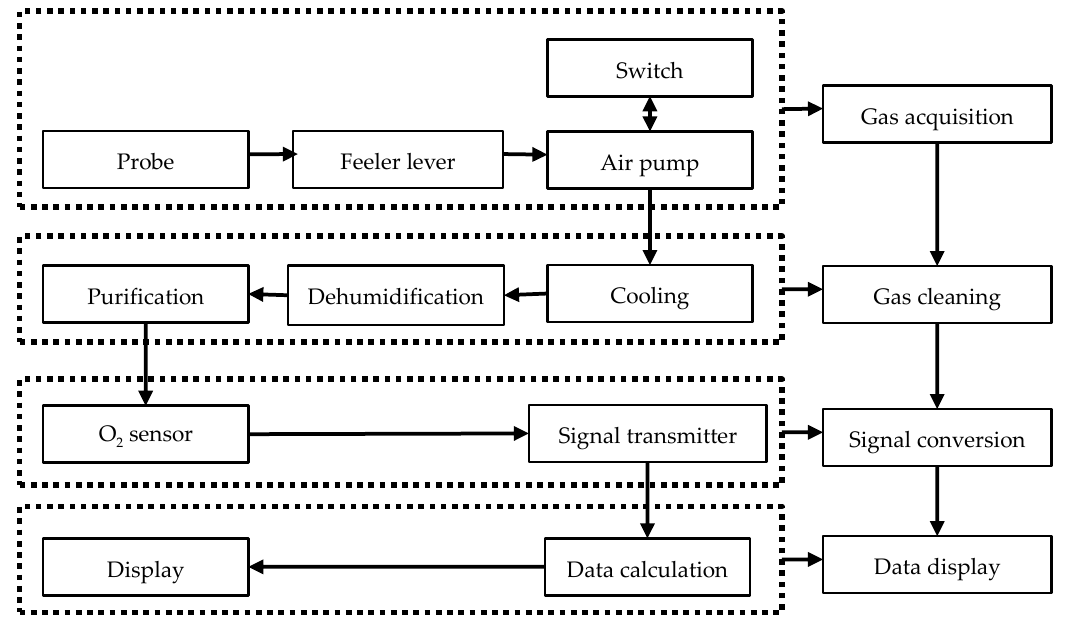
Figure 1. Schematic diagram of the equipment structure.